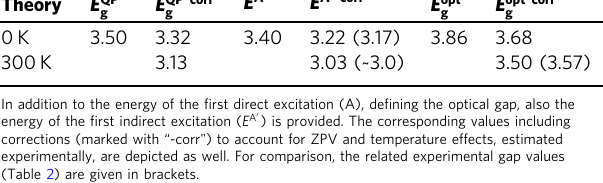
, as given by G 0 W 0 @HSE06 at g , obtained by the BSE [in eV]. g